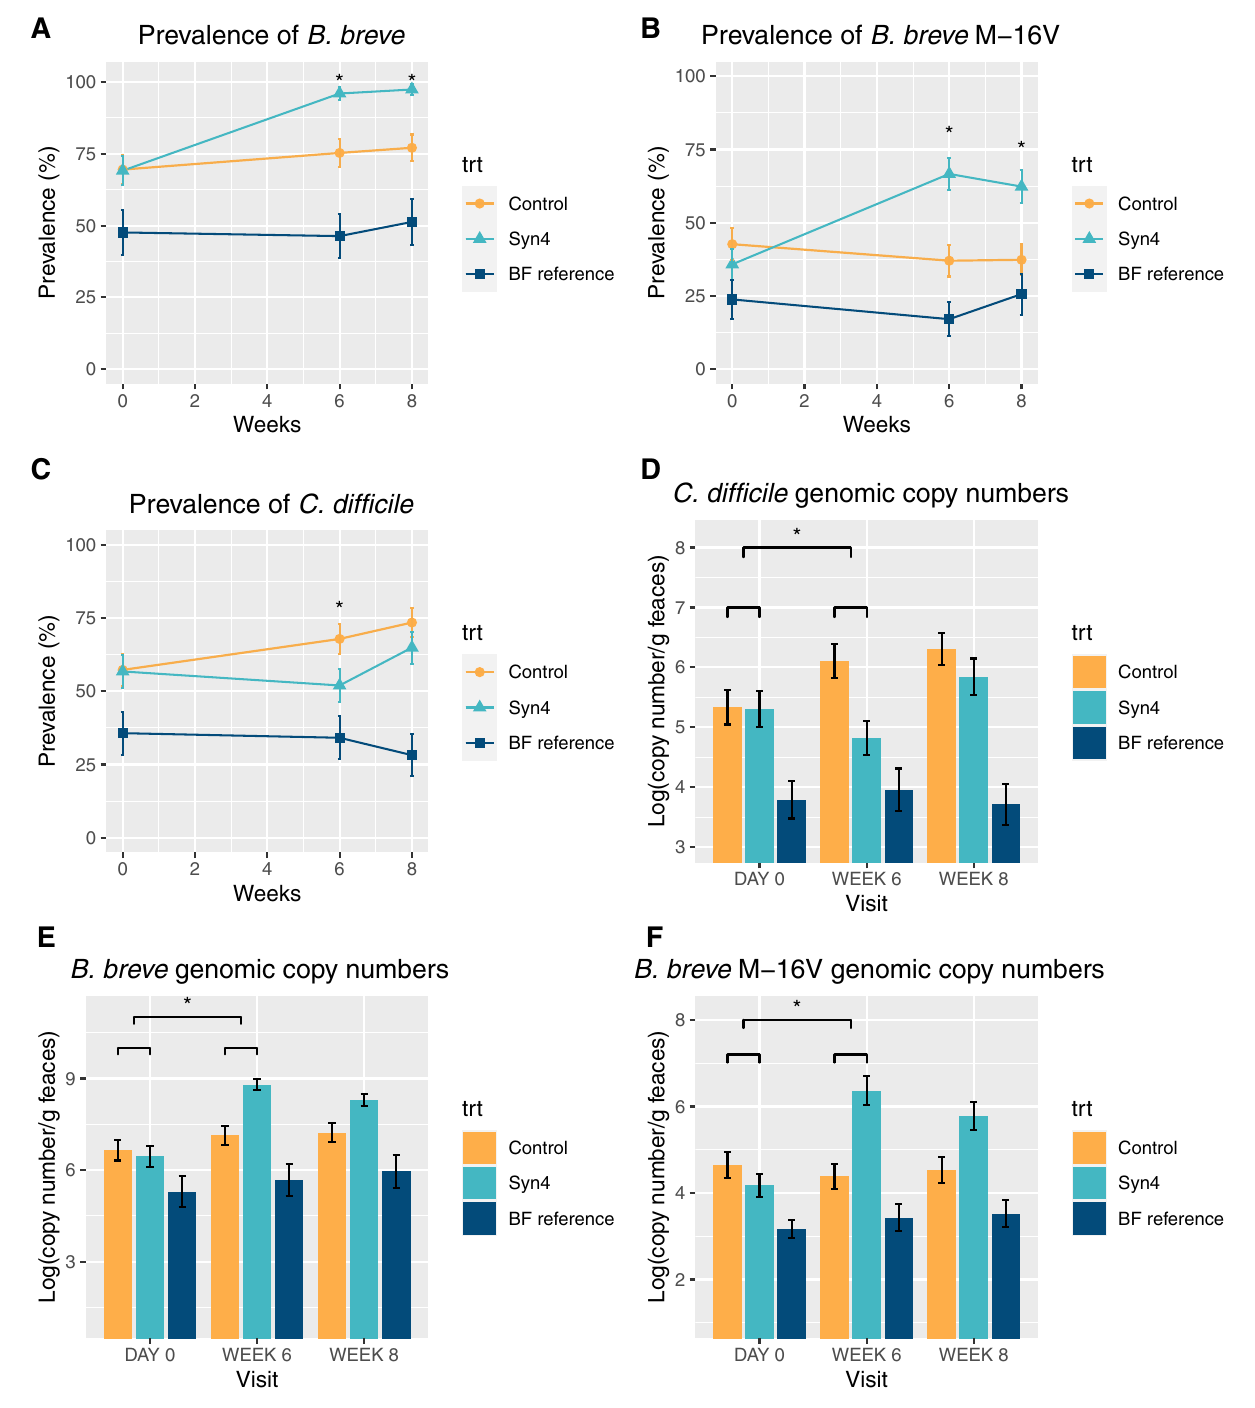
Figure 4. q-PCR analyses showed that the Syn4 dose resulted in a significantly larger increase in prevalence of (mean percentage of infants with detectable) B. breve ( A ) and B. breve M-16V ( B ) and a significantly larger decrease of C. difficile prevalence ( C ) as compared to control treatment. Detected C. difficile genomic copy numbers decreased significantly more in the Syn4 group compared to the control group ( D ). The increase in total amount of bifidobacterial copy numbers from baseline was only significantly larger (p = 0.0079) at Week 6 in the Syn4 group compared to control ( E ). Increase in the B. breve M-16V copy numbers from baseline was significantly larger in the Syn4 group compared to control at both Week 6 and Week 8 (respectively p < 0.0001 and p < 0.0001) ( F ). A generalized linear mixed model (GLMM) was used with intervention, time, study site as fixed factors, intervention by time as interaction term and subject as a random effect for the analysis of the binary transformed (detected/non-detected) data and the estimation of prevalence of detected values. A longitudinal linear mixed-effect model was used with intervention, time, study site as fixed factors, intervention by time as interaction term and subject as a random effect for the genomic copy number analysis. Data are expressed as mean ± SE. *Statistically significant differences in change from baseline between treatment groups (p-value < 0.05) as assessed by the linear or generalized linear mixed